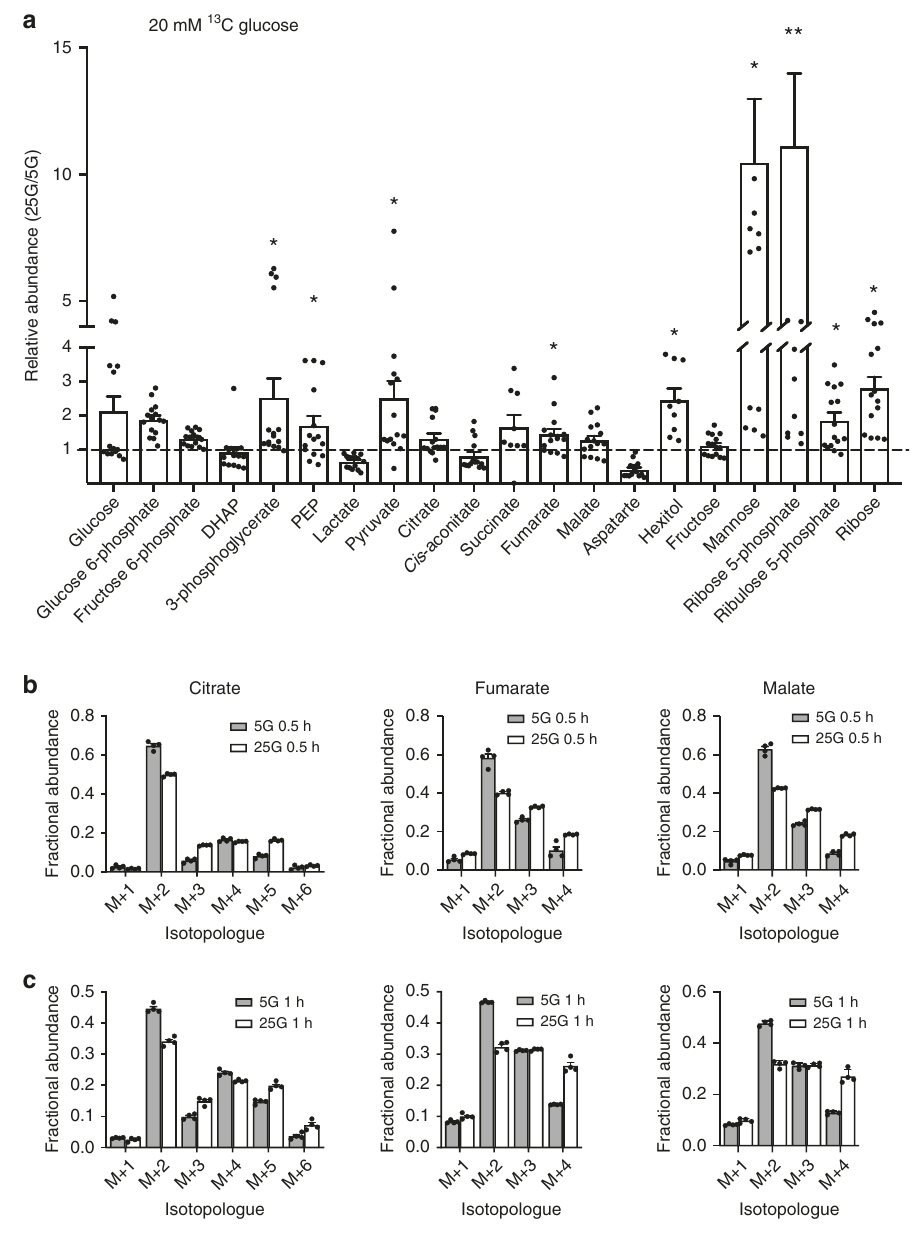
Fig. 9 Metabolite abundance and isotopomers in response to hyperglycaemia. a Relative abundance of the indicated metabolites in INS-1 cells cultured at 25 mM expressed as a fraction of that in INS-1 cells cultured at 5 mM glucose. All cells were challenged with 20 mM [U- 13 C]-glucose for 30 min. DHAP, dihydroxyacetone phosphate. PEP, phosphenolpyruvate. Hexitol (sorbitol/mannitol). Data are mean ± s.e.m. ( n = 15 independent samples except for hexitol and succinate where n = 9). One-way analysis of variance with Holm – Sidak ’ s multiple comparisons test, * p < 0.05, ** p < 0.01. b , c Mass isotopomer distributions (MIDs) of the indicated metabolites in INS-1 cells cultured at 5 mM glucose (white bars) or 25 mM glucose (black bars) and then challenged with 20 mM [U- 13 C]-glucose for 30 min ( b ) or 60 min ( c ). Data are derived from a subset of that used in Fig. 8. Mean ± s.e.m.; n = 4 independent samples. ‘ M + n ’ (where ‘ M ’ is the m / z of the unlabelled ion) and ‘ n ’ indicates the number of 13 C atoms in that isotopomer. The data for each isotopomer are expressed as a fraction of the total labelled isotopomers for that metabolite. Since pyruvate and acetyl-CoA contain three and two carbons, respectively, MIDs of + 3 are indicative of carbon entry into the TCA through carboxylation of pyruvate, + 2, + 4 and + 6 are indicative of entry through acetyl-CoA (multiple cycles), while + 5 indicates that it is derived from both pyruvate carboxylation and